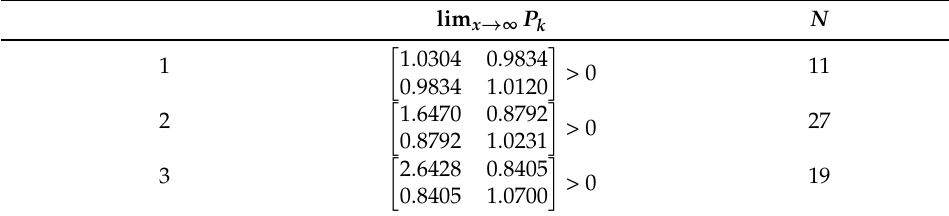
Table 3. Results of three sets of simulation